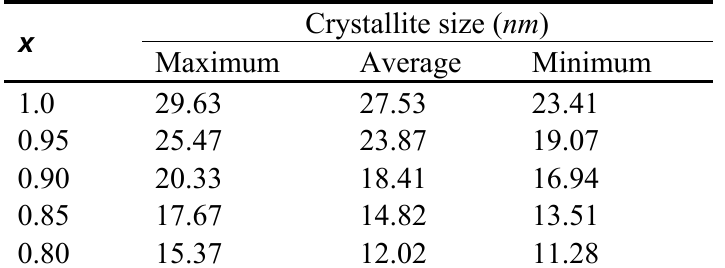
Table 1. Crystallite size of the samples versus level of doping.